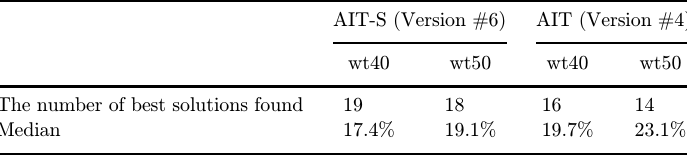
Table 5. Best solution found by AIT (Version #4) and AIT-S (Version